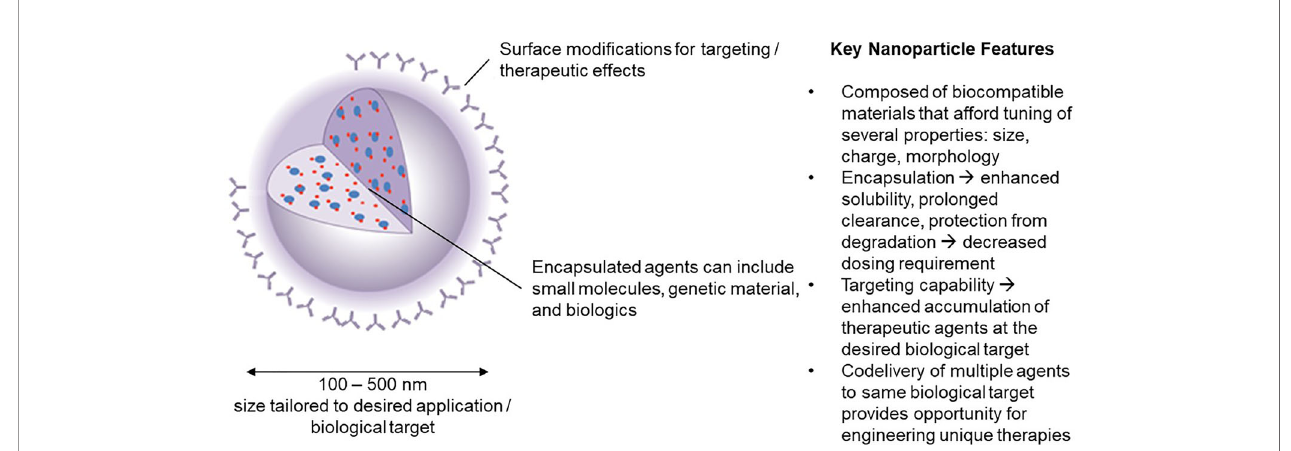
FIGURE 1 | Nanoparticle carriers offer a unique set of characteristics that have inspired signi fi cant interest in their use in engineering novel immunotherapies in the fi eld of tolerance